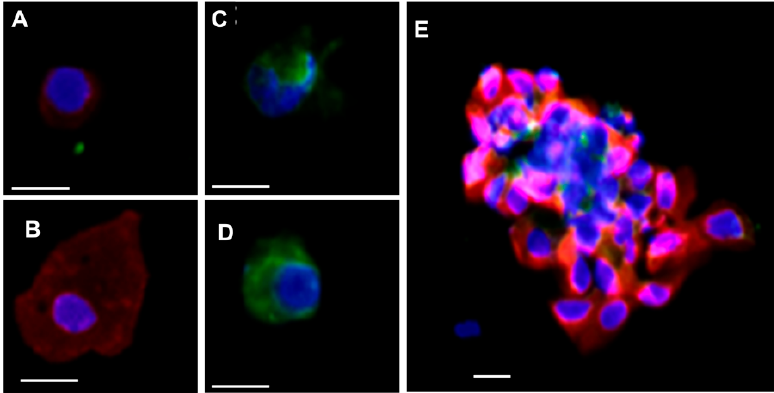
Figure 3. The immunostaining and morphology of captured cells by the mCMx platform. The cells were immunostained with CD45 (green), PanCK (red), and DAPI (blue) nuclear stain. ( A ) The PanCK+/CD45 − /DAPI+ cells were identified as CTCs. ( B ) The PanCK+/CD45 − /DAPI+ cells with low N/C-ratio were not counted as CTCs. ( C , D ) The PanCK − /CD45+/DAPI+ cells were defined as leukocytes. ( E ) Multiple cell clusters containing PanCK+/DAPI+ and or CD45+/ − were defined as CTC clusters or CTC microemboli (all the images were acquired by Leica DMI6000 B. Scale bar = 10 µ